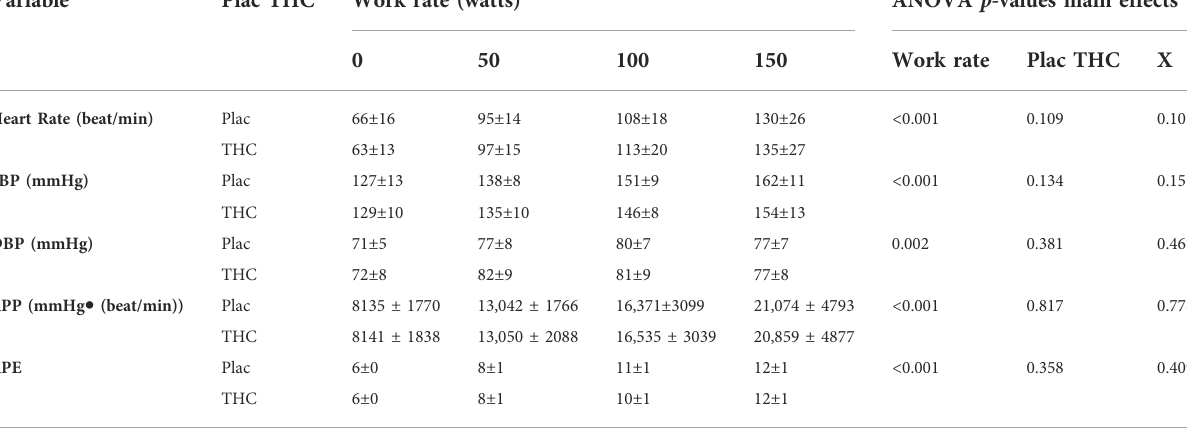
TABLE 2 Cardiovascular responses and ratings of perceived exertion during standardized stationary cycle ergometer exercise following ingestion of edible marijuana or placebo.